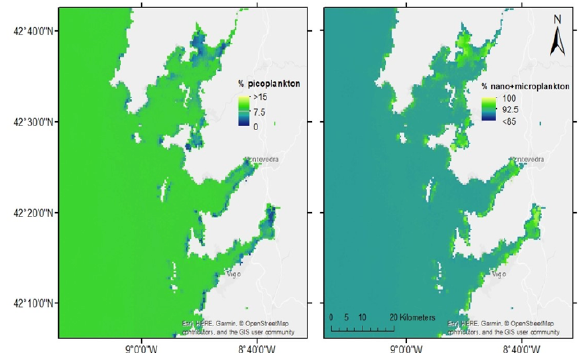
Figure 6. Example of PSC map over Galician rias based on S-3 images. C1 – picoplankton. C2,3 – nano- +